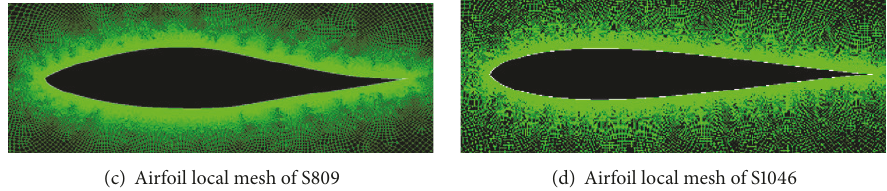
Figure 4: Grid mesh of computing model.